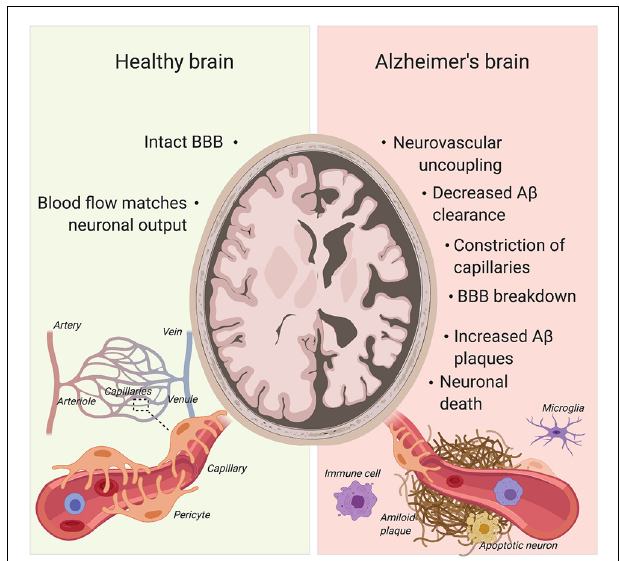
FIGURE 4 | Pericytes’ role in Alzheimer’s disease (AD) pathogenesis. Pericyte degeneration causes neurovascular uncoupling and blood-brain barrier (BBB) breakdown. Through the accumulation of blood products, BBB disruption triggers vascular-mediated secondary neuronal injury, degeneration and cognitive impairment in AD. Given that pericytes are able to clear A β , pericyte loss also results in A β accumulation in the brain. A β can cause constriction of brain capillaries at pericyte locations. Created with